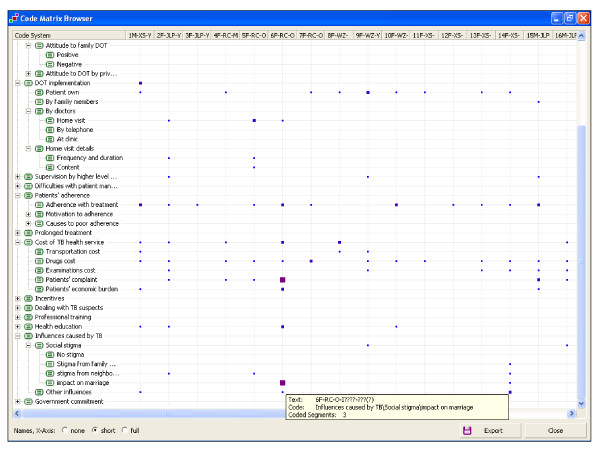
Code matrix browser.